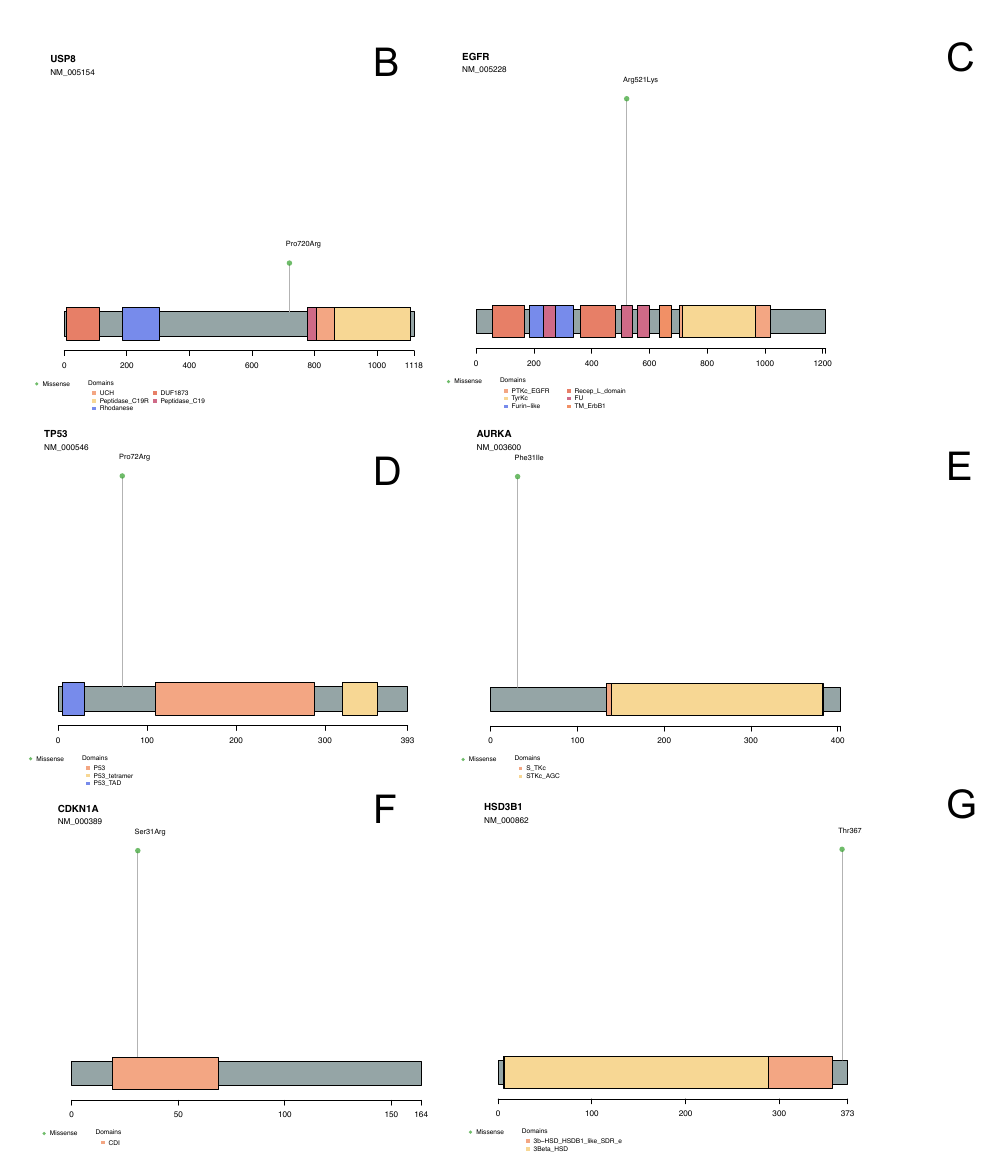
Figure 3. Panel ( A ) shows the oncoplot from the missense variants of the selected genes and their clinical–pathological features. Panels ( B – G ) depict USP8, EGFR, TP53, AURKA , CDKN1A and HSD3B1 proteins, respectively, with the changes found in DNA impacting aminoacidic changes. In general, the pituitary CA presented more CNV alterations than the benign tumors, with 27 and 32 cytogenetic regions showing gains and losses of genetic material, respectively. The cytogenetic regions showing gains were 10q11.22, 15q11.2, 16p12.3, 1p13.2 and 20p, where genes SYT15, POTEB, ARL6IP1, HIPK1 and CJD6 are coded, respectively. By contrast, 8p21.2 was the cytogenetic region showing loss of genetic material. The previously reported amplification of 1p13.2 was also detected in this tumor (Figure 4)